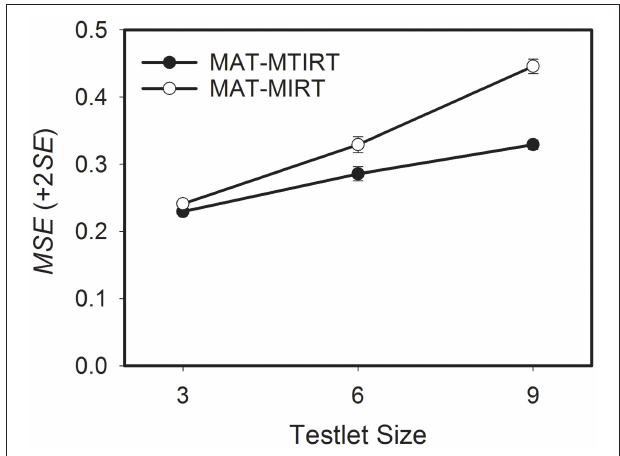
FIGURE 3 | Average mean square error ( MSE ) of the ability estimates obtained by MAT with the MTIRT and the MIRT model as a function of testlet size. Testlet effect variance = 1.000.